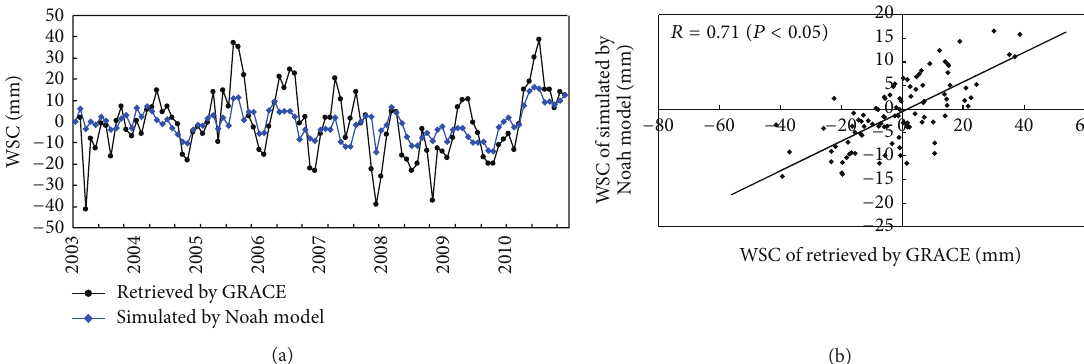
Figure 3: Correlation of WSC retrieved by GRACE and simulated by Noah as time